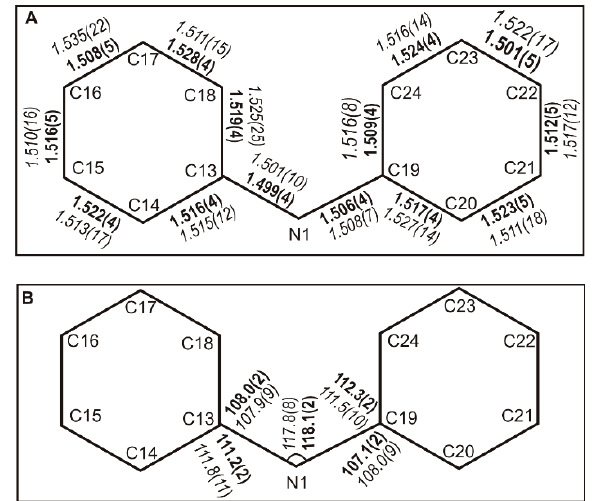
Figure 5 . Structural comparison of the cation moiety of the title compound. ( A ) Bond lengths of the dicyclohexylammonium moiety are shown with the average literature values extracted from the Cambridge Structural Database (CSD). ( B ) Selected bond angles of the cation moiety of the title compound are marked with the literature values. The bond lengths and angles of the title compound are shown in boldface and the average bond lengths, and bond angles calculated from the 14 model structures extracted from the CSD are shown in normal italic.